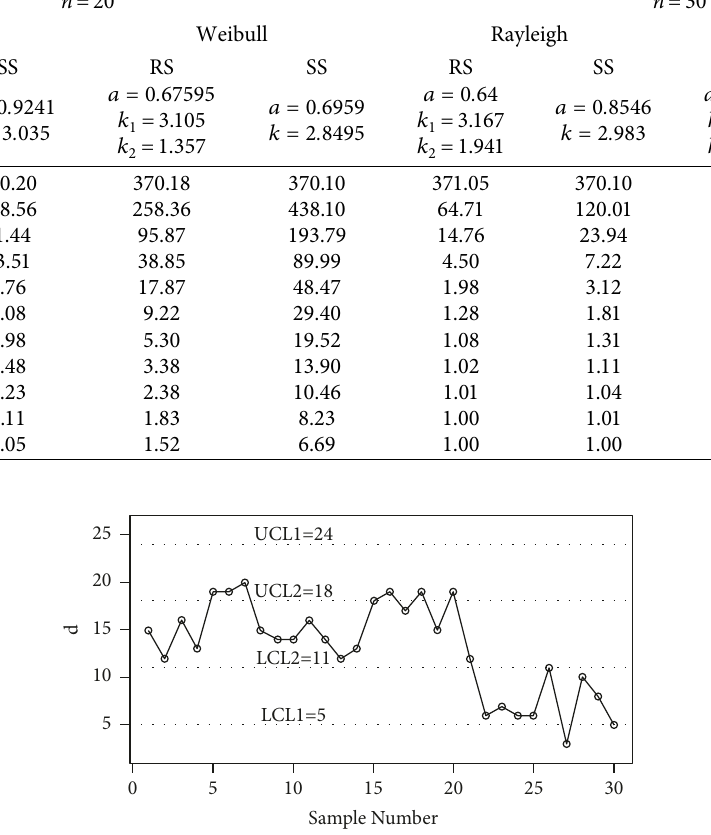
Figure 1: The proposed control chart for simulated data.